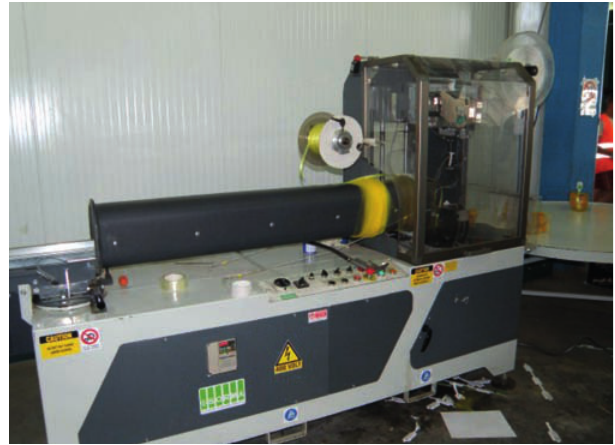
Fig. 11: Net bagger for 1 kg